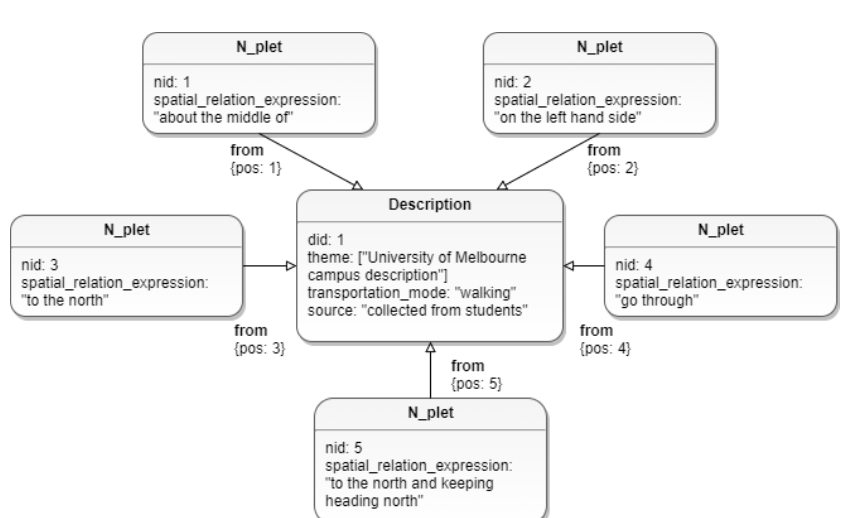
Figure A1. Creation of description and user nodes.